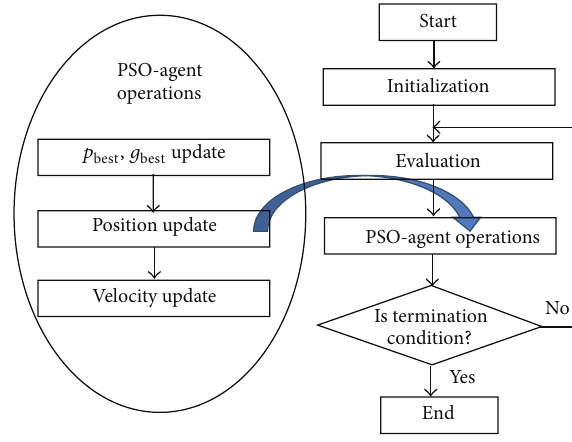
Figure 2: Evolution process of a GA-agent. Figure 3: Evolution process of a PSO-agent.